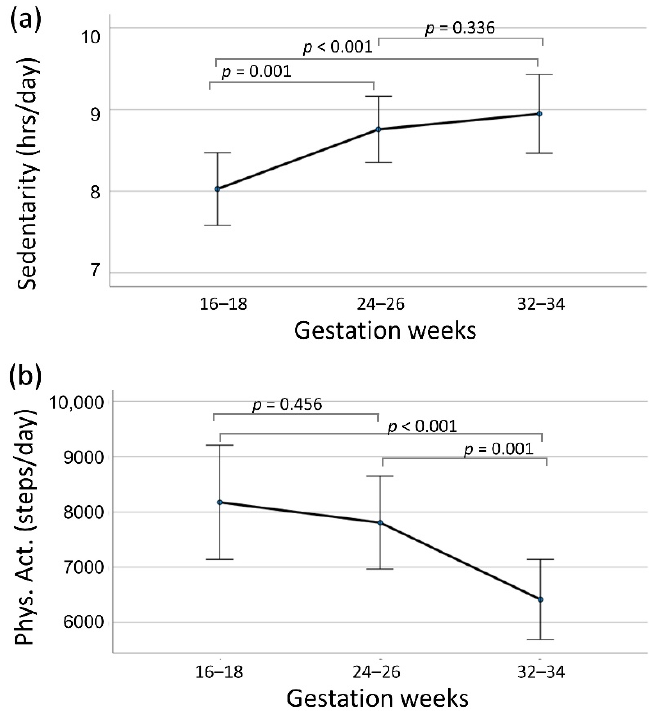
Figure 1. Mean sedentary behavior ( a ) and physical activity ( b ) at each evaluation period. Bars represent 95% confidence intervals. Table 2. Results of simple linear regression models testing relationships between ( a ) sedentary behavior and ( b ) physical activity with birthweight-for-gestational age